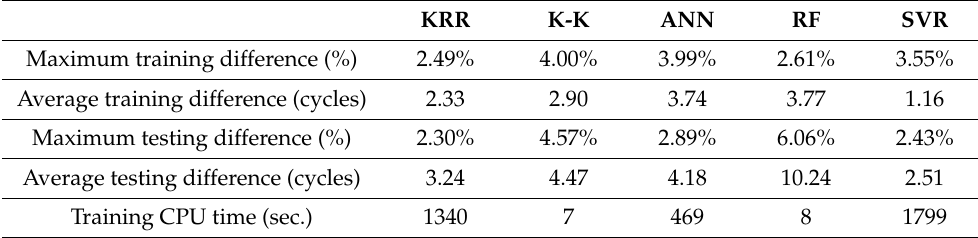
Table 17. The comparison of machine learning algorithms.